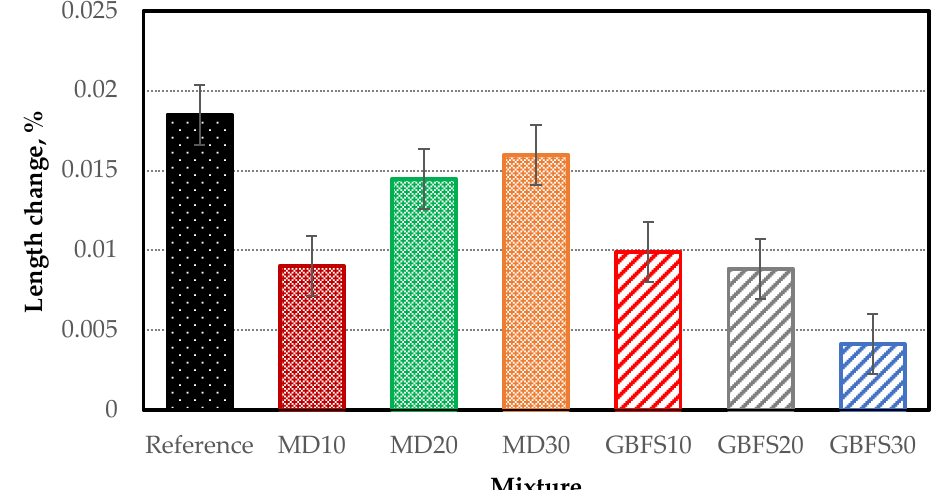
Figure 9. Length chance of the specimens after sulfate exposure.